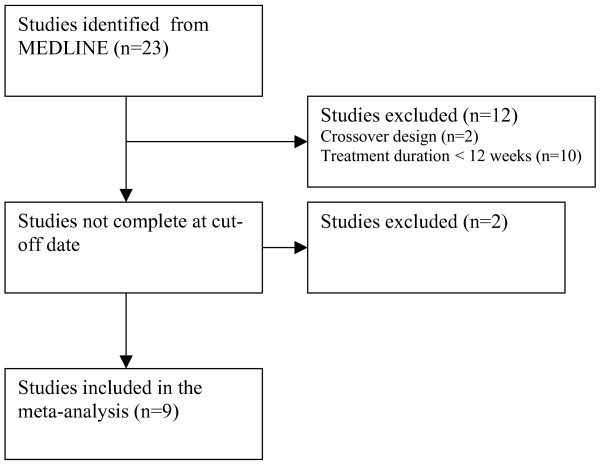
Flow diagram of the trial selection process.